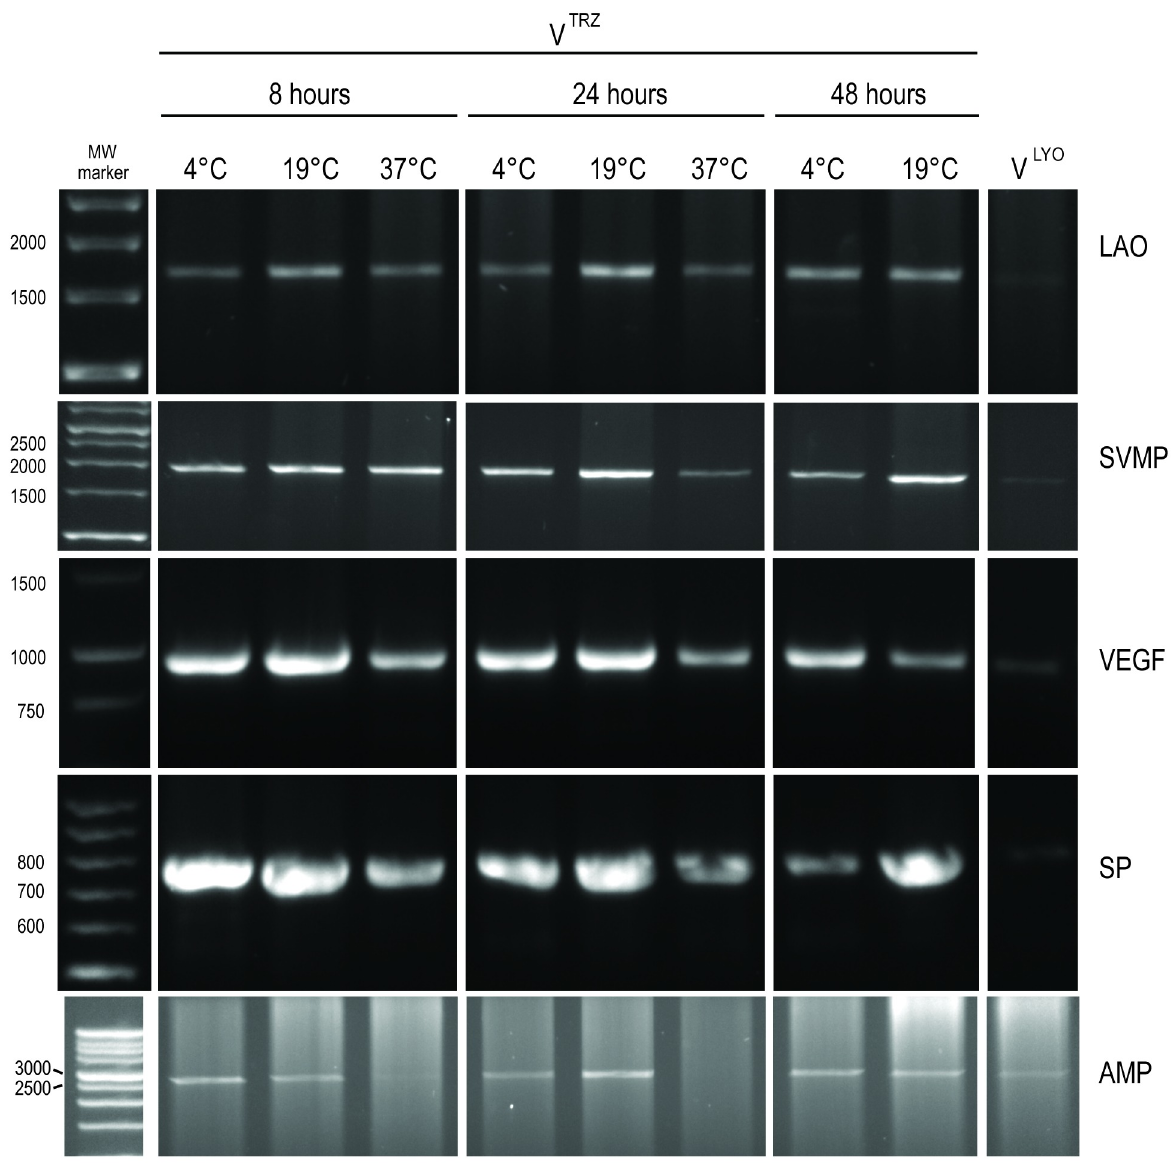
Fig 4. PCR amplification of Bitis arietans genes from V TRZ after incubation with TRIzol for a range of storage times and temperatures and V LYO . L-amino acid oxidase (LAO), snake venom metalloproteinase (SVMP), vascular endothelial growth factor (VEGF), serine protease (SP) or aminopeptidase (AMP). Molecular weight markers are shown on the left (base